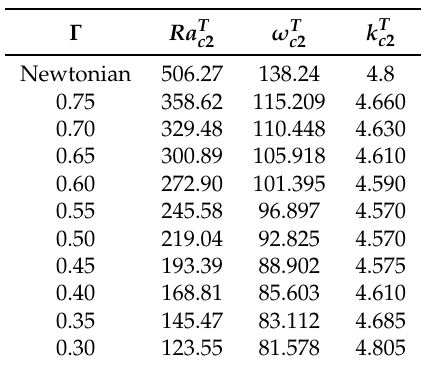
Table 1. Critical Rayleigh number Ra T transverse rolls as a secondary instability for λ 1 = 0.1 and different values of Γ .